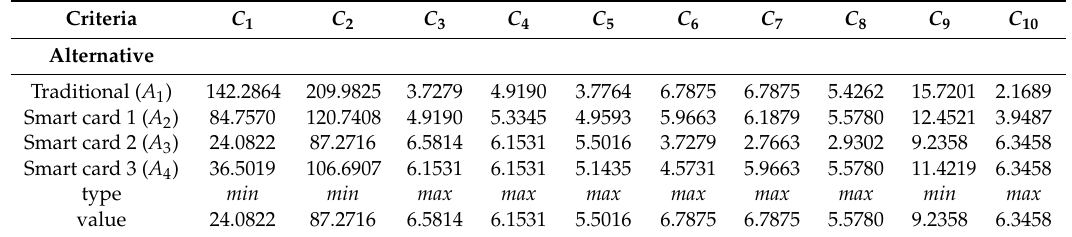
Table 4. Initial group decision